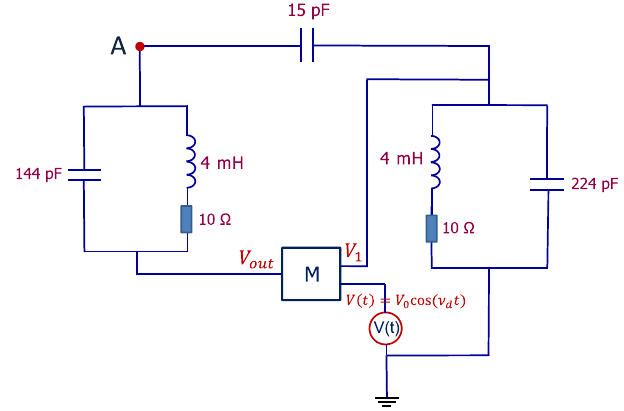
FIG. 5. Experimental setup: Two RLC circuits are connected by a capacitor and a multiplier M , which yields nonreciprocal coupling between the two circuits. The transfer function of the multiplier is given by Eq. (55). Sinusoidal voltage from a function generator is applied to one of the multiplier’s inputs, which produces modulation of the coupling strength. Voltage ð t Þ at the point A is measured by an oscilloscope. V A